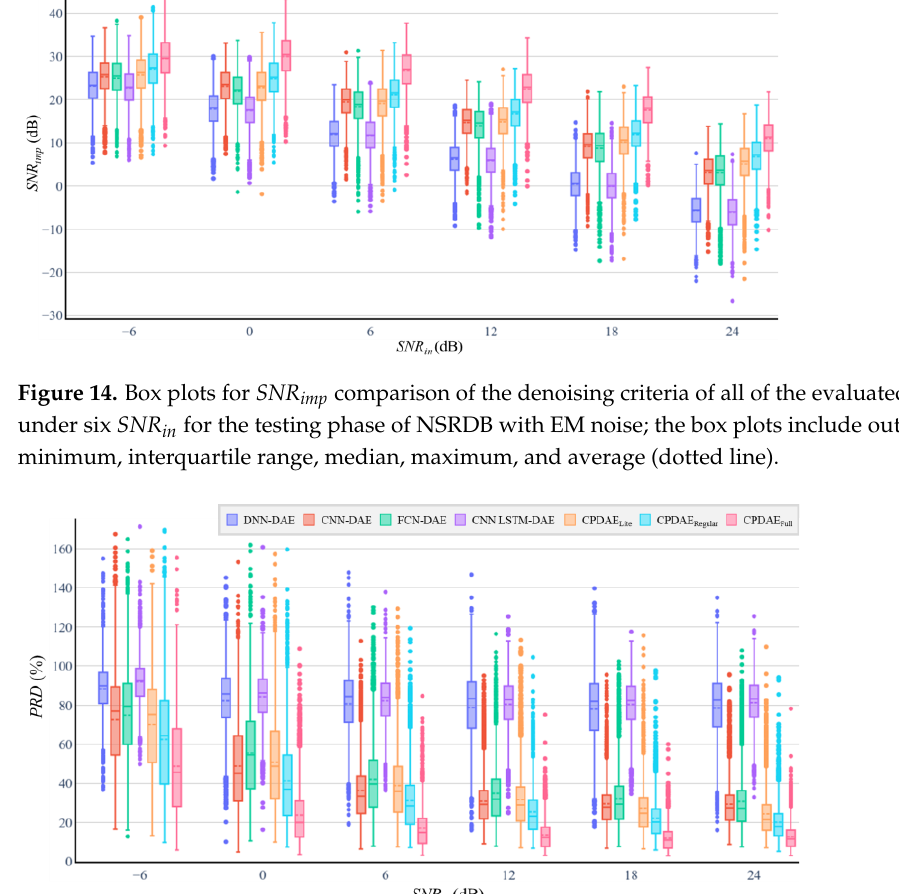
Figure 15. Box plots for PRD comparison of the denoising criteria of all of the evaluated methods under six SNRin for the testing phase of NSRDB with EM noise; the box plots include outliers (dot), minimum, interquartile range, median, maximum, and average (dotted line).